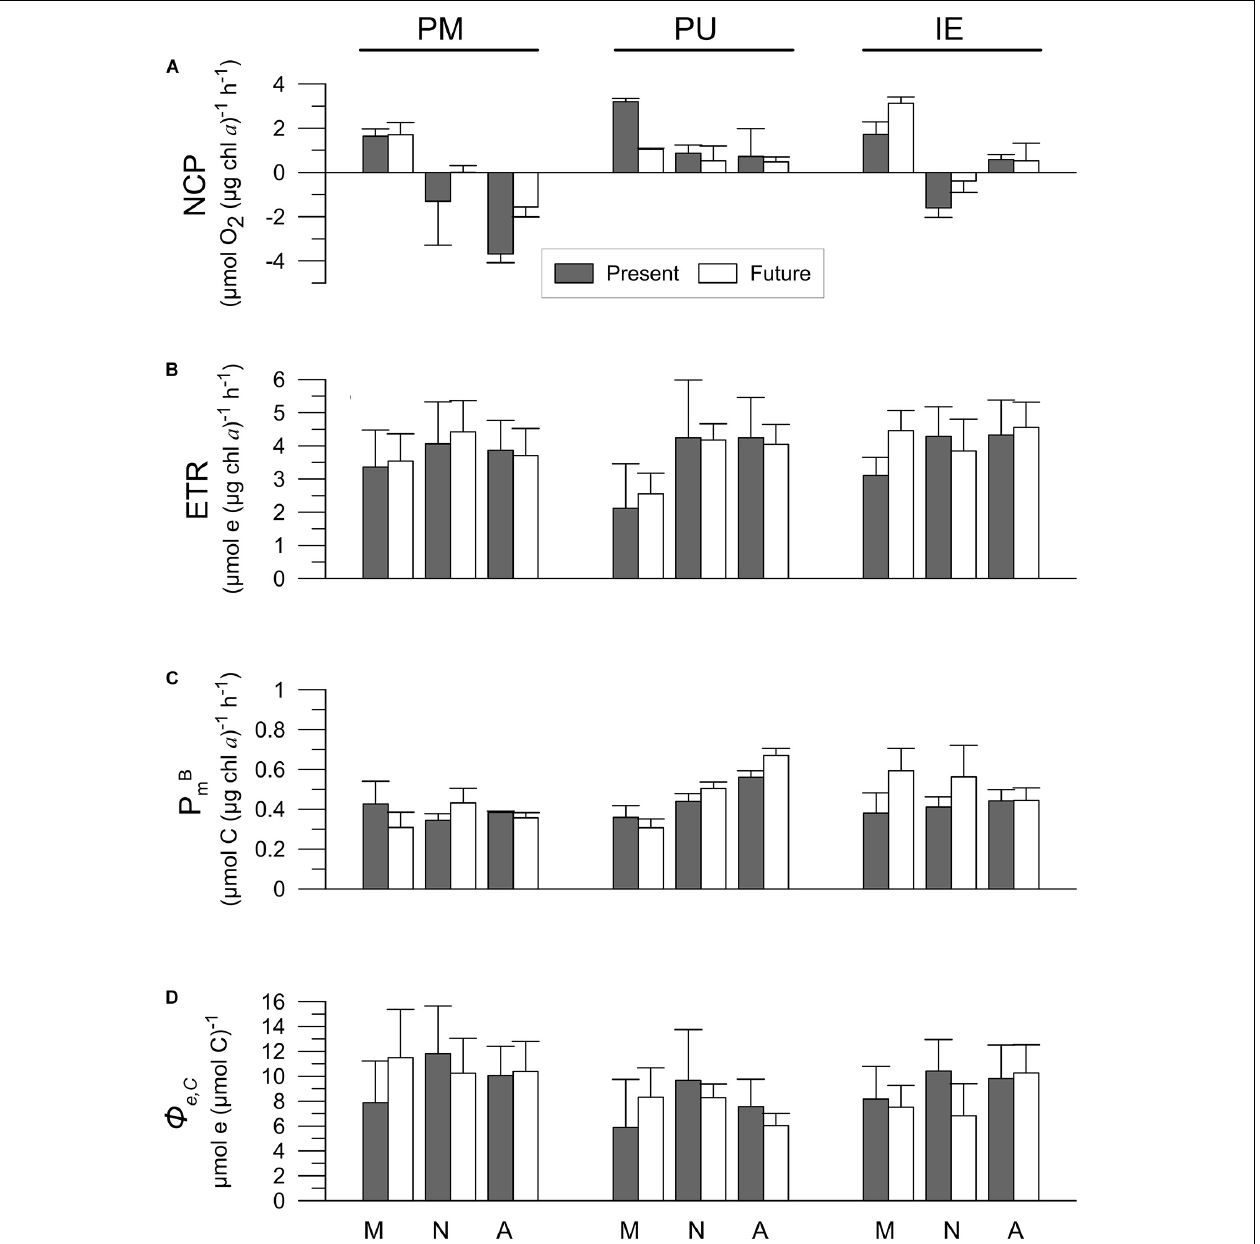
FIGURE 5 | (A) Net community productivity (NCP); (B) electron transport rates (ETR); (C) assimilation numbers (P mB ), and (D) ratio of ETR and P mB ( (cid:56) e , C ) of the samples collected in Puerto Madryn (PM), Playa Unión (PU) and Isla Escondida (IE) after being acclimated for 2 days under the Present (Pres) and Future (Fut) scenarios. M, N and A letters indicate morning, noon and afternoon, respectively. Lines on the top of the bars indicate standard